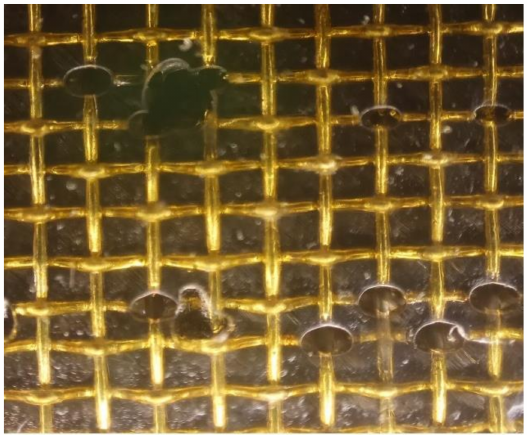
Figure 14. Microscopic image of central region of B20.